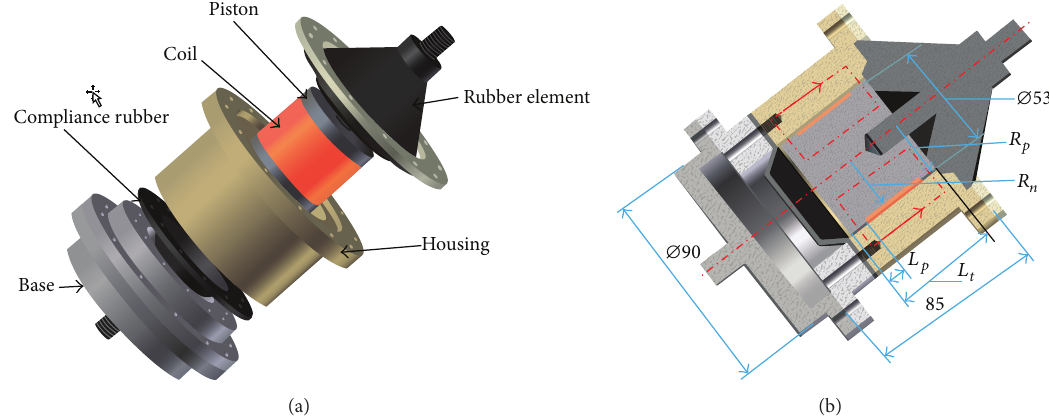
Figure 20: (a) Configuration of traditional MR mount and (b) cross section of traditional MR mount.